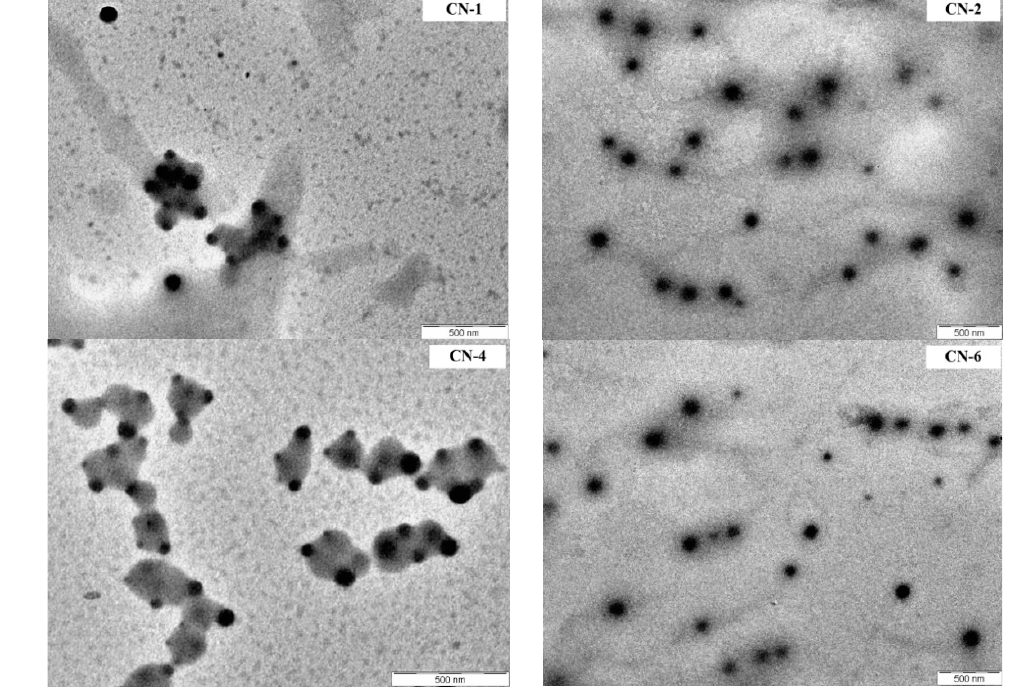
Figure 4. TEM images of CN-1, CN-2, CN-4 and CN-6 samples.